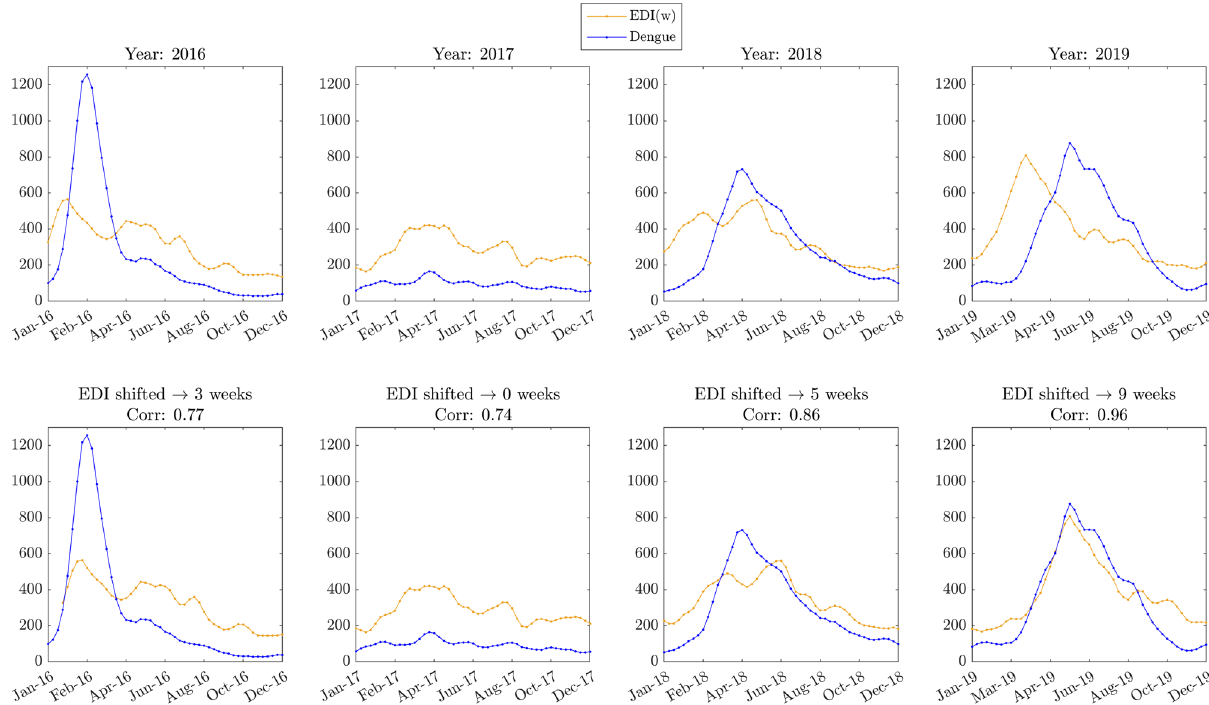
Figure 4. Dengue and EDI by annual periods. Upper panels show Dengue Incidence and EDI aggregated for the municipality; the time series are categorized yearly, from 2016 to 2019. The bottom panels illustrate Dengue Incidence and EDI, but the EDI time series was shifted for visualizing the best correlation. For all panels, aggregated EDI was estimated by weighting the values for the neighborhoods by the respective population. The neighborhood with the higher population was multiplied by 1, and the remainder was multiplied by a proportional